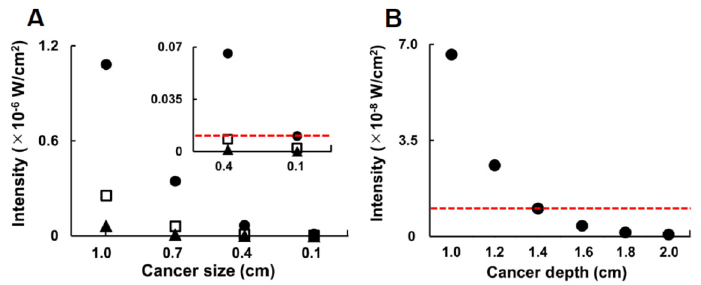
Figure 6. Effect on the detected fluorescence intensity of cancer size ( A , 0.1–1.0 cm) and cancer depth ( B , 1–2 cm). Insert is enlarged on the axis of the intensity. Closed circles: SWIR, Open squares: NIR, Closed triangles: VIS. The red broken line denotes the detectable intensity of 10 nW/cm 2 .